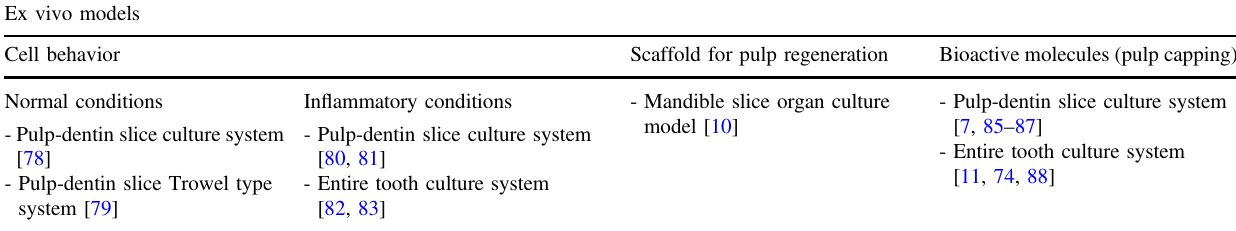
Table 3 Ex vivo models for dental pulp regeneration Ex vivo models Cell behavior Scaffold for pulp regeneration Bioactive molecules (pulp capping) Normal